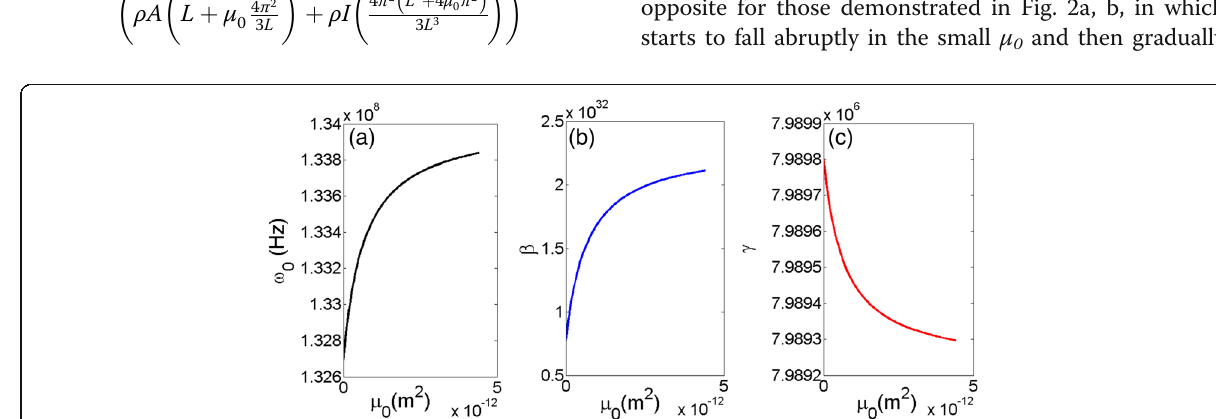
Fig. 2 The calculated results of resonate frequency ω 0 ( a ), Duffing coefficient β ( b ), and damping ratio γ ( c ) related to the nonlocal coefficient μ